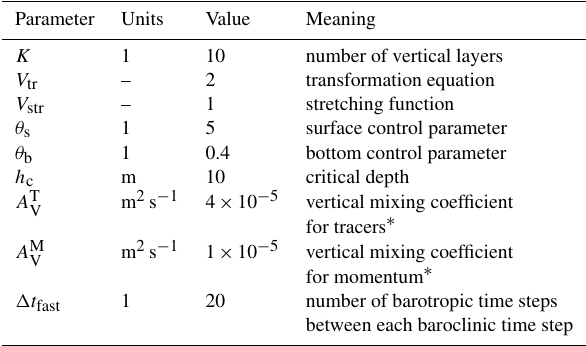
Table 1. Parameter settings and the equations used common to all ROMS